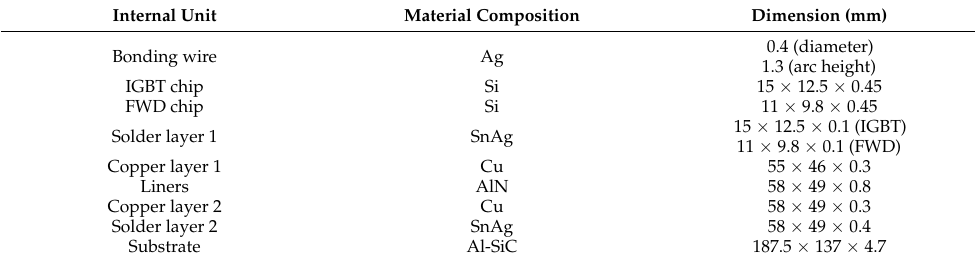
Table 2. IGBT module dimensions.